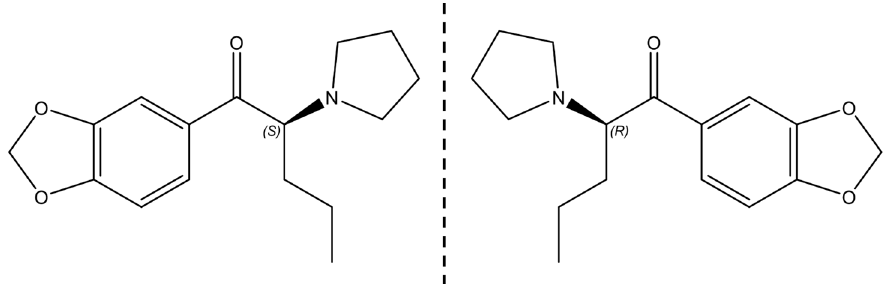
Figure 1. Structures of MDPV enantiomers.